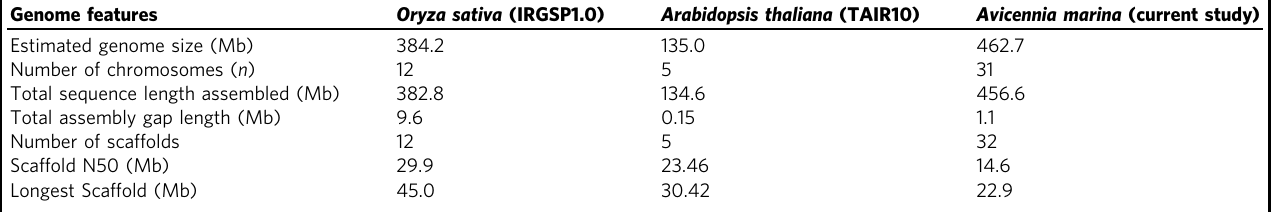
Table 2 Comparison of A. marina genome assembly (AmGA_v1.0) to other high-quality genomes. Genome features